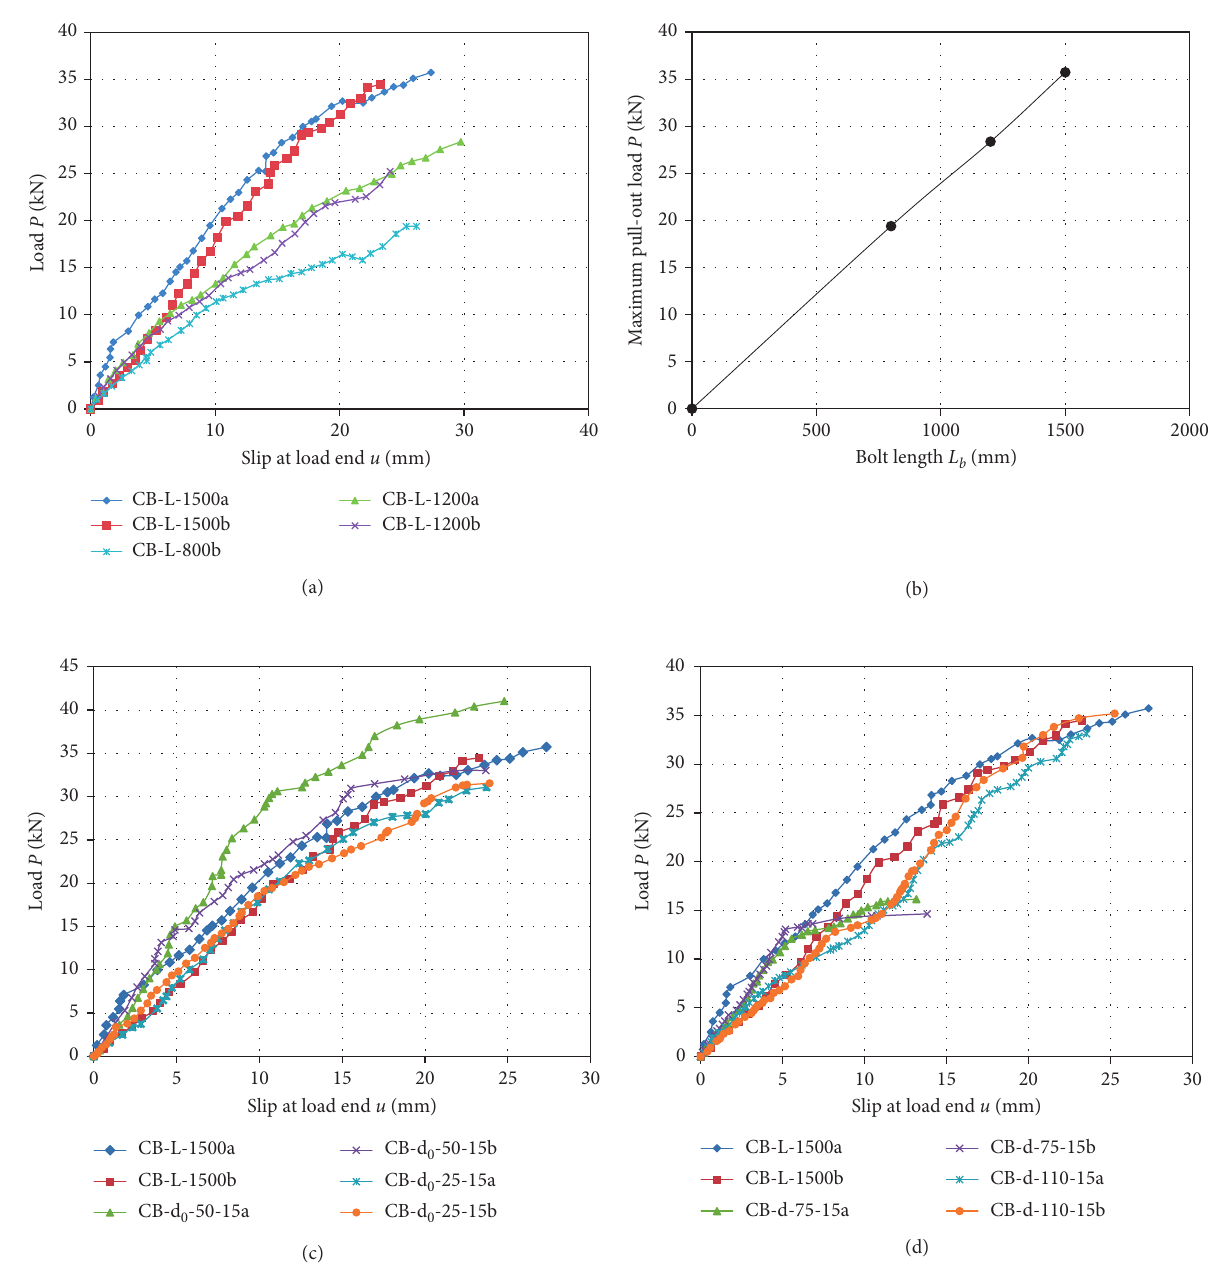
Figure 12: Load-displacement curve of short bolt specimens ( L < L eff ). (a) Different bolt lengths. (b) Maximum pull-out load-bolt length relationship. (c) Different bolt diameters. (d) Different bolt hole